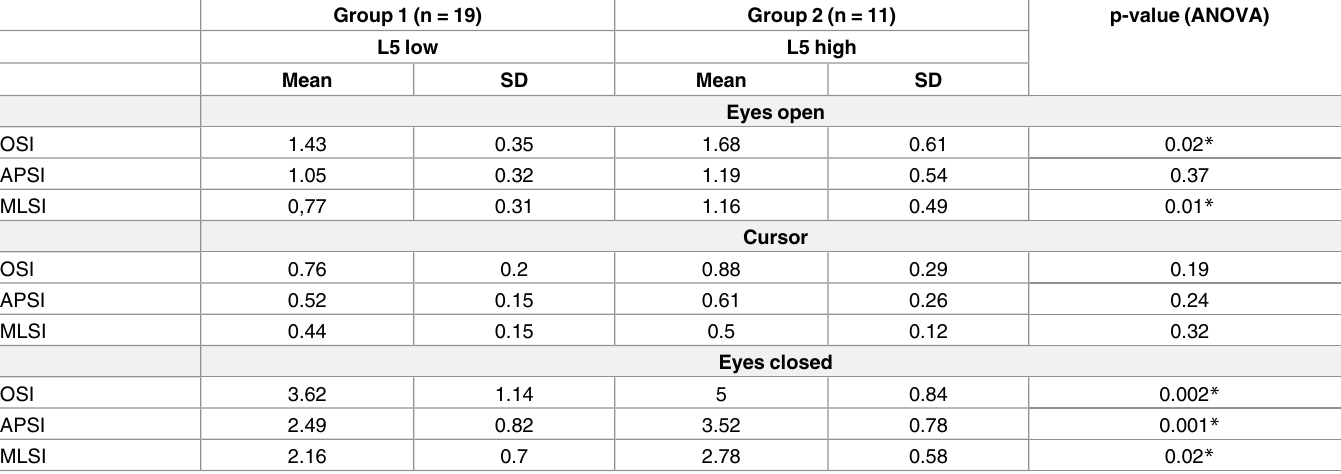
Table 2. Stability index score with decreasing platform stability (30 s tests from level 12 to 1. Dynamic test 1).